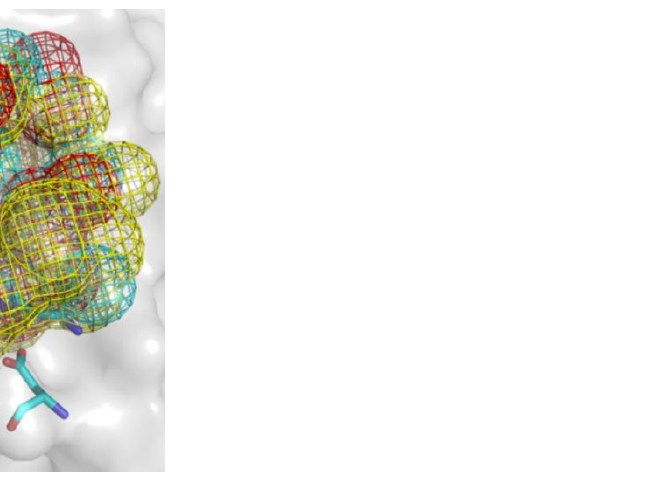
Figure 1. A comprehensive picture of all MIFs and the corresponding catalophores computed for the active site of Thc_cut1. The residues forming the catalytic triad are highlighted inside the cavity. Legend for the catalophores obtained using the corresponding probes: yellow: hydrophobic; red: H-bond donor; cyan: H-bond acceptors.